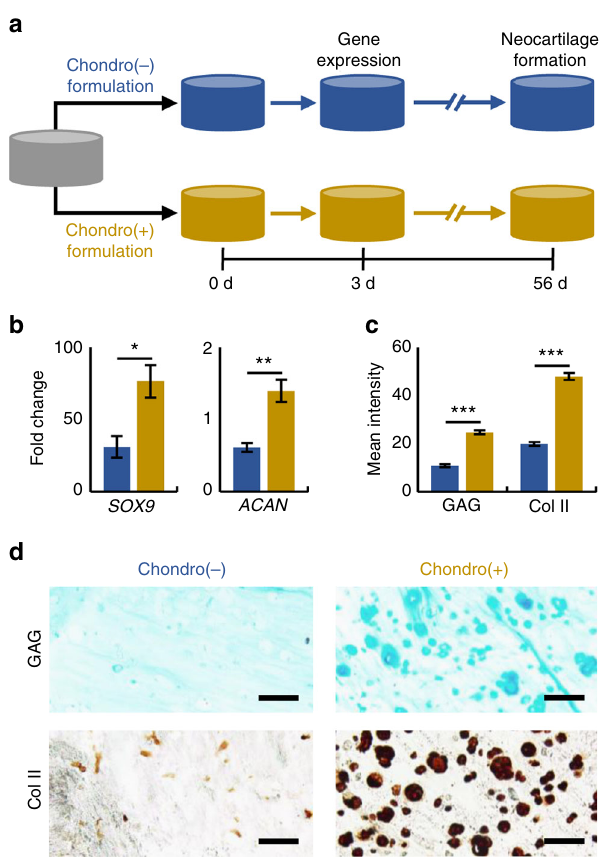
Fig. 7 Discrete hydrogels with high HAV and low RGD enhance neocartilage formation by MSCs in vitro. a Overview of discrete hydrogel study where mesenchymal stem cells (MSCs) were photoencapsulated in norbornene-modi fi ed hyaluronic acid (NorHA) hydrogels and then biofunctionalized with a 5 mM peptide solution consisting of either “ Chondro(+) ” (4.5 mM HAV and 0.5 mM RGD) or “ Chondro( − ) ” (4.5 mM RGD and 0.5 mM HAV) peptide formulations, and assayed for early (3- day) and long-term (56-day) gene expression and neocartilage formation, respectively. b Gene expression of SOX9 and ACAN (aggrecan) after 3 days for MSCs in Chondro(+) and Chondro( − ) hydrogels ( n = 4 hydrogels per group). c Quanti fi cation and d images of histology and immunohistochemistry for glycosaminoglycan (GAG) and type II collagen (Col II) after 56 days ( n > 50 sections per group). Error bars represent standard error around the mean (s.e.m.); *** p < 0.001, ** p < 0.01, * p < 0.05 compared to the Chondro( − ) condition. Scale bars: 100 µ